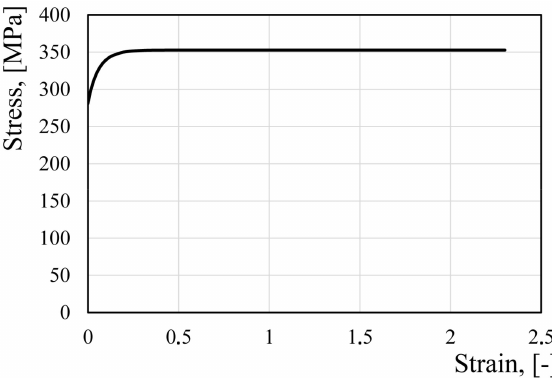
Figure 4. Existing Hocket–Sherby model of the flow stress of the AA3104-H19